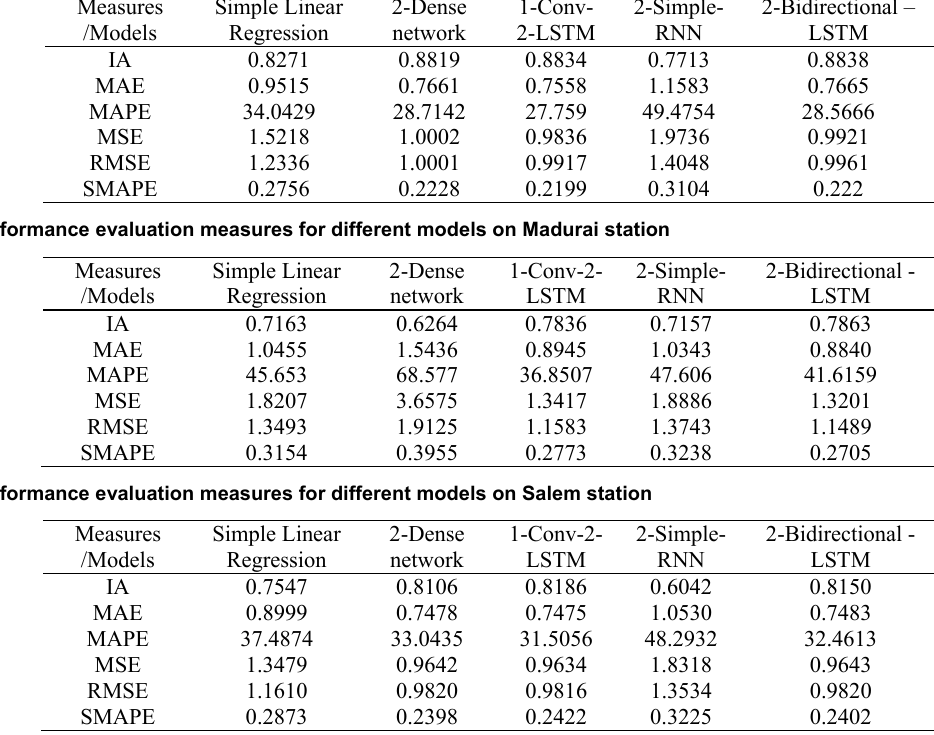
Table 7. Performance evaluation measures for different models on Tirunelveli station